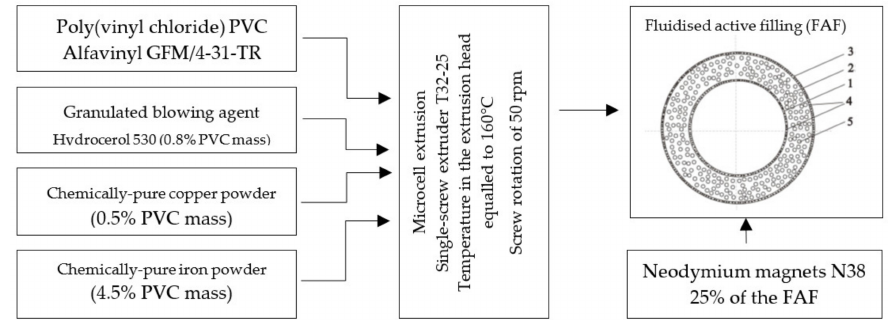
Figure 1. Scheme of fluidized active filling (FAF) production (1—inter layer with metal powder, 2—middle cellular layer with blowing agent, 3—outer layer with metal powder, 4—metal particles,